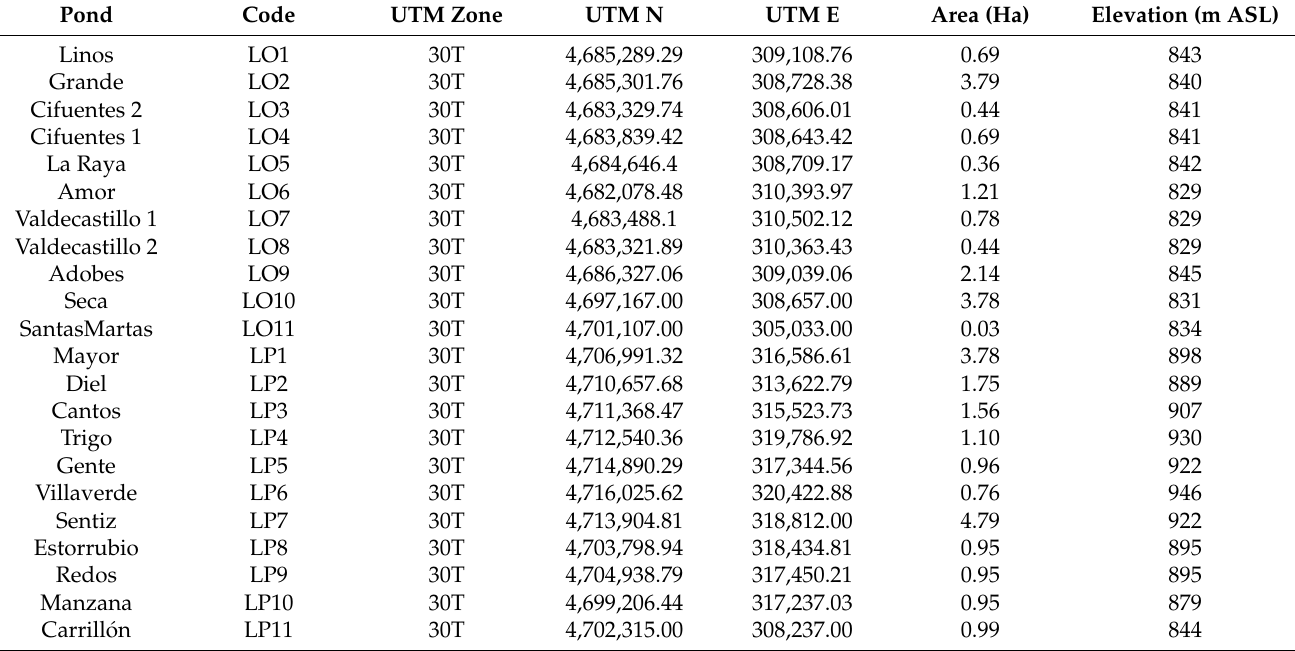
Table 1. Ponds sampled in the Duero River Basin, NW Spain, including code, name, geographical coordinates, area, elevation (m above sea level